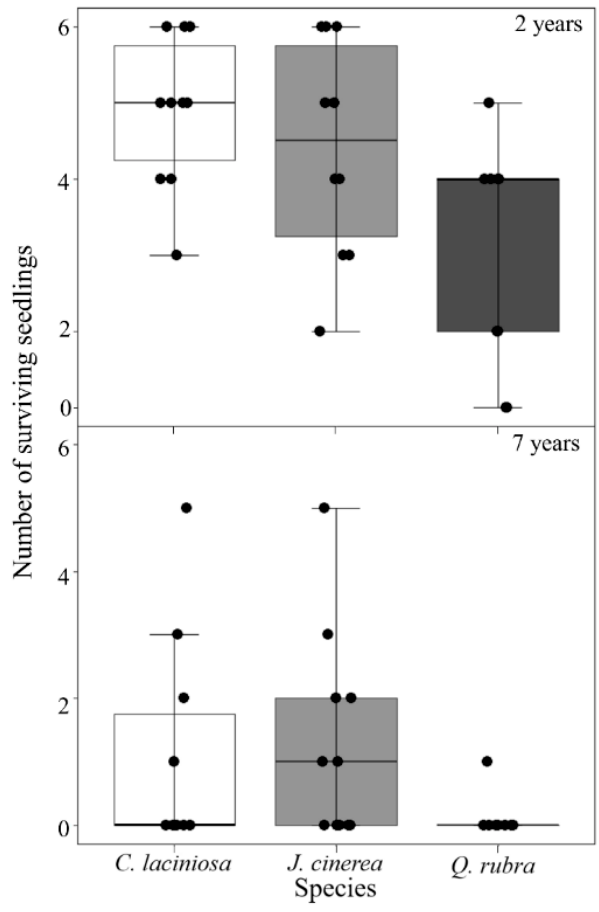
Figure 1. Survivorship of three species of tree seedlings ( Carya laciniosa, Juglans cinereal, and Quercus rubra ) planted in a temperate forest understory in southwestern Ohio, USA, during a forest restoration experiment. Seedlings were assessed after two and seven years and the maximum number of seedlings possible in each plot was six. The center of each box represents the median and each point represents the number of seedlings in each of ten plots.